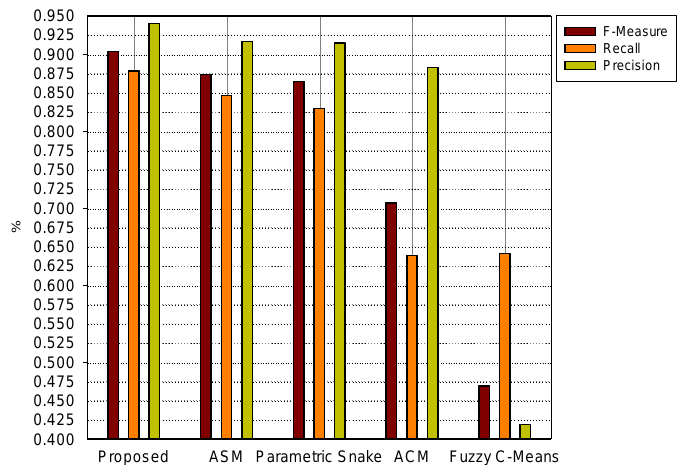
Figure 10. The final comparative results of the F-measure, recall and precision with respect to other state-of-the-art methods. ASM, active shape